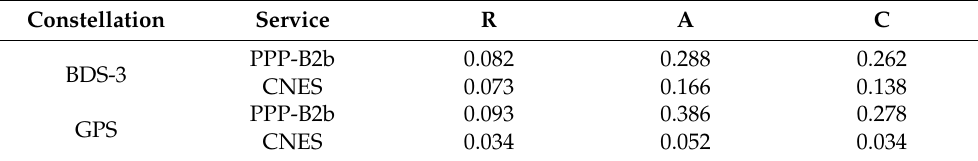
Table 4. Average RMSEs of BDS-3 and GPS orbits in the RAC directions (in meters). Constellation